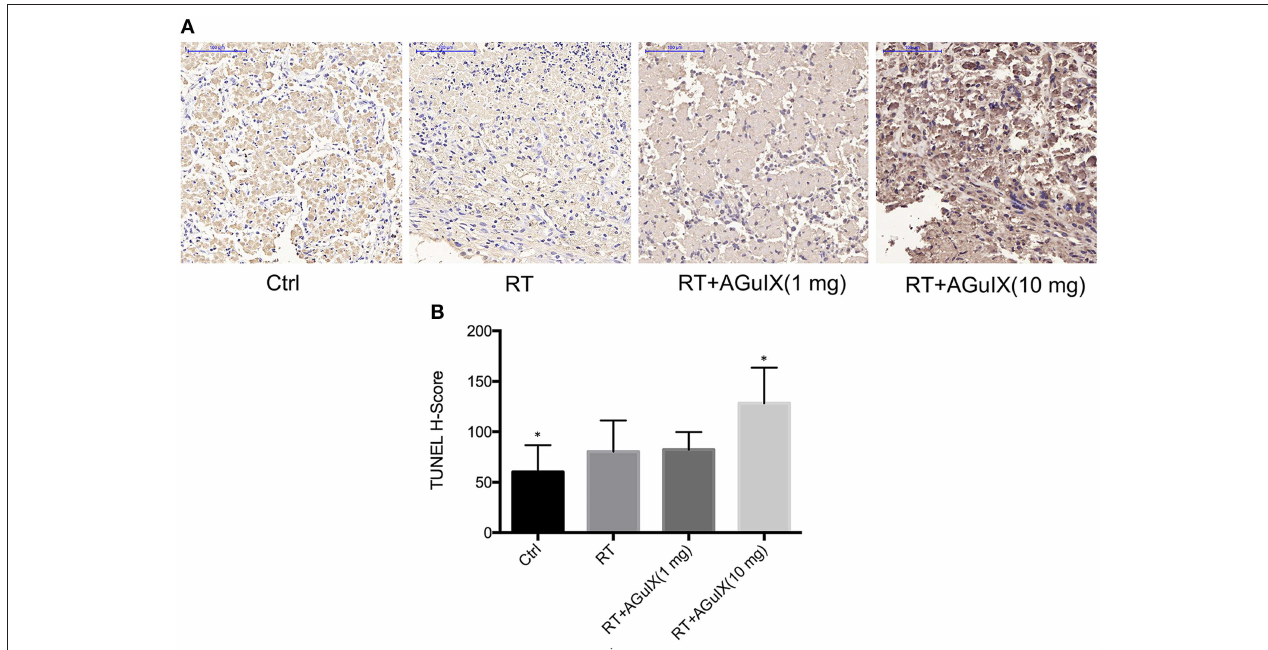
FIGURE 6 | Pathology and immunohistochemistry of tumor tissues. (A) Microscopic images of TUNEL ( × 200) staining of tumor tissues obtained from HepG2-bearing mice with no therapy were used as control. In TUNEL staining, apoptotic cells are stained brown. (B) Data analysis using the H-SCORE of TUNEL staining of tumor tissues to compare the four groups. Independent-sample t test was used for statistics. The asterisk indicates statistical significance ( P < 0.05).